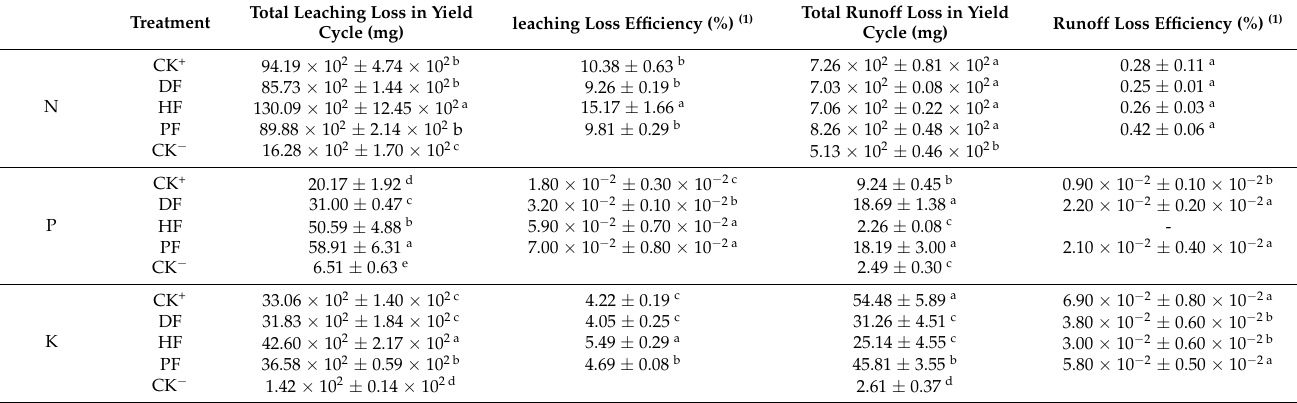
Table 2. NPK leaching and runoff losses in different fertilization